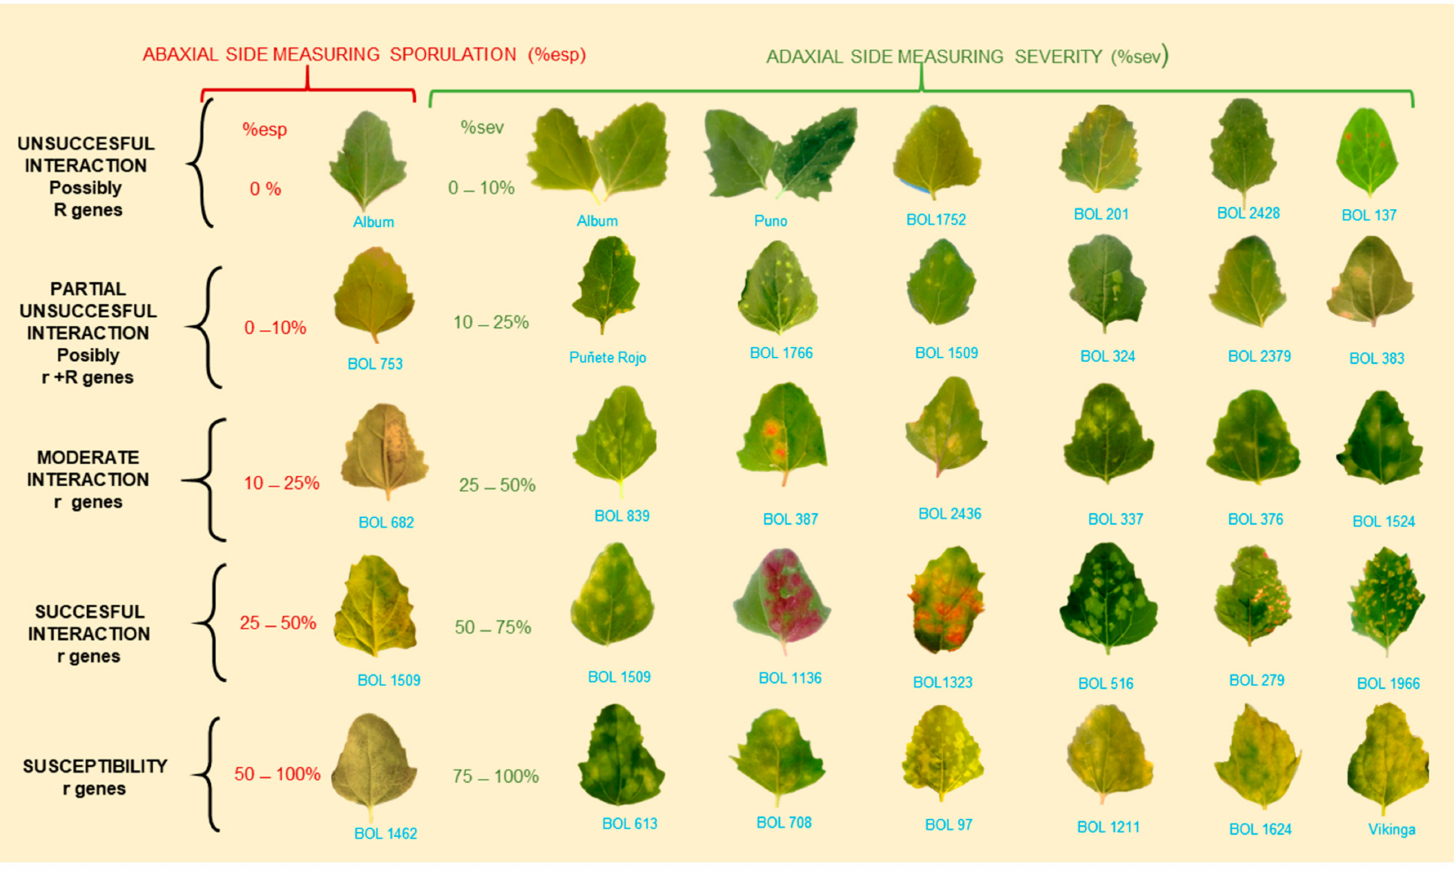
Figure 9. Scale for percentage of severity and sporulation area affected by downy mildew in quinoa. r = postulated minor genes; R = hypothesized major genes. BOL = accession numbers. Note : Percentage of sporulation is estimated on the abaxial leaf side area covered by visible lesion. It is not estimated on the total abaxial side leaf area (Colque-Little et al., 2021) [52]. Photos by